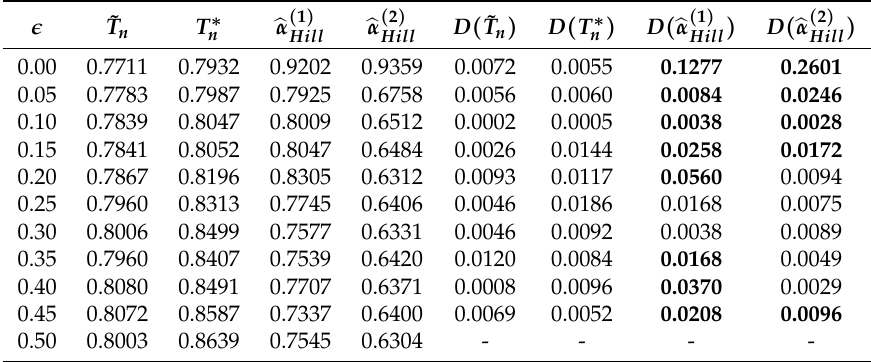
Table 2. Estimations of Weibull tail coefficient and its relative deviations via contamination level (cid:101) = 0.05 i , i = 0, . . . ,10. Data is the positive and scaled log returns of daily CRIX during 31 July